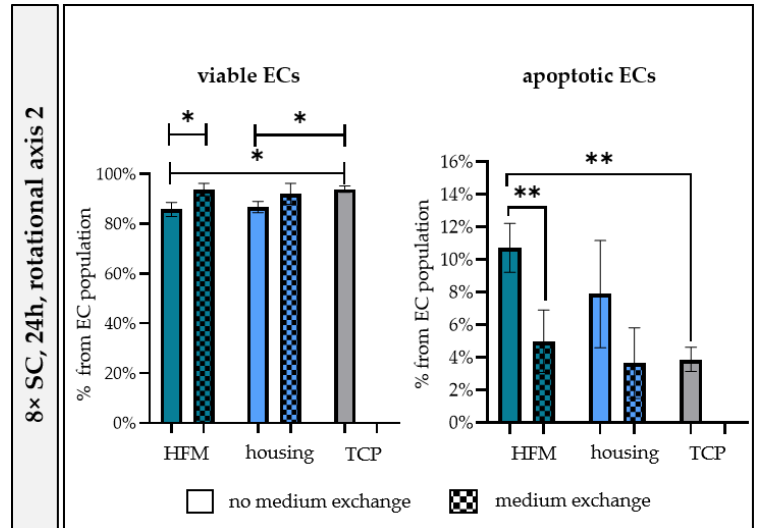
Figure 6. Medium exchange during 24 h seeding procedure recovered viability and mitigated apoptosis of ECs on MOx. Flow cytometry data of viable and apoptotic ECs obtained after rotational seeding around RA2 with 8 × SC for 24 h, with or without MExch. TCP: tissue culture plastics, SC: seeding concentration. * p < 0.05, ** p < 0.01.